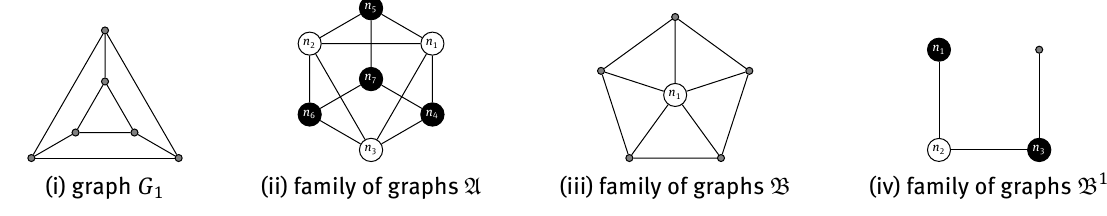
Figure 1: The family of graphs C . A black vertex represents a clique of cardinality n v , a white vertex represents a stable set of cardinality n v and a gray vertex represents a single